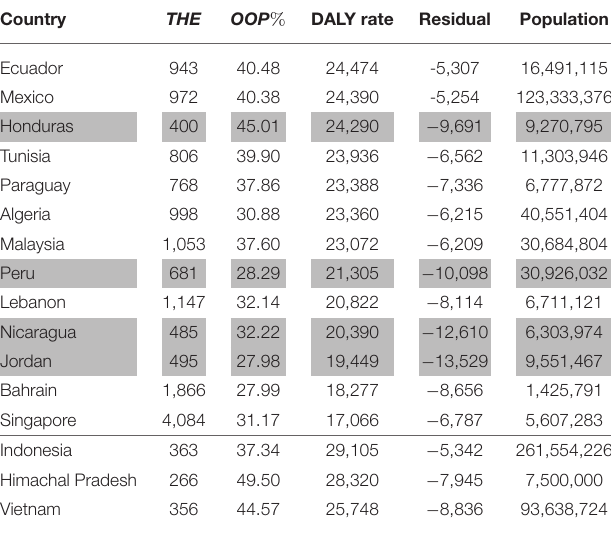
TABLE 7 | Negative outlier countries with THE > $ 1,000. Country THE OOP % DALY rate Residual Population United